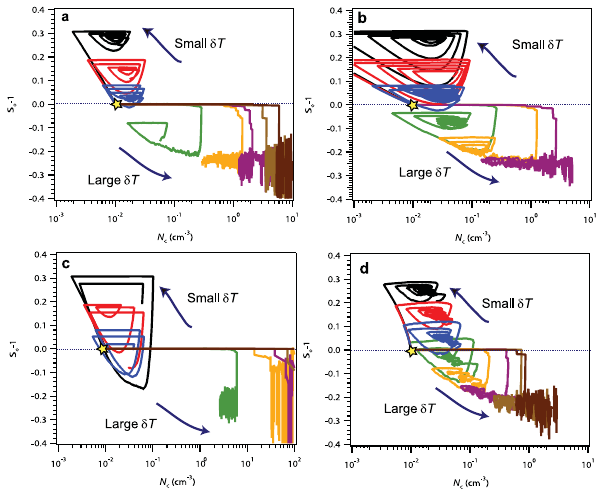
Fig. 6. Sensitivity of N c and S o evolution to cloud formation con- ditions for different values of δT (color scheme same as in Fig. 4); (a) same conditions as in Fig. 4, (b) cloud thickness, H = 100m (increased ice crystal removal rate), (c) deposition coefficient equal to 0.006 (Magee et al., 2006) (slow water vapor transfer), and (d) initial temperature 225K and cloud lifting at 5cms − 1 . The yellow star in each panel indicates initial conditions. The arrows indicate the temporal progression along each trajectory. The integration time was 40h cases, except in (d) were it was 15h. Fig. 7. Similar to Fig. 6, but varying cloud mean vertical velocity, ¯ u ,